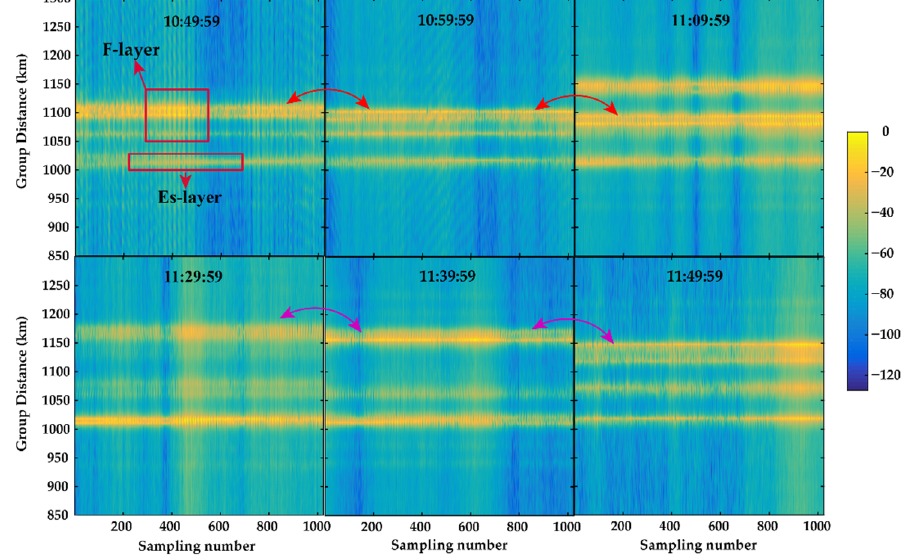
Figure 15. The OIS ionogram of ESB-HR from 10:49:59 to 11:49:59.